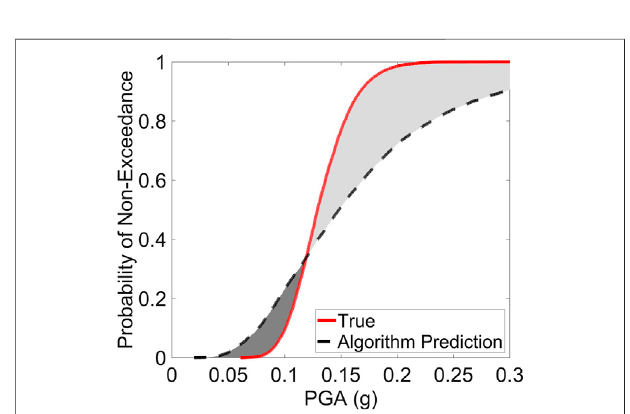
FIGURE 4 | Demonstration of the GMM evaluation procedure, which measures the difference between the true and estimated GMM CDF for a given set of location and magnitude predictions. The light gray shading indicates PGA exceedance thresholds for which the predicted ground shakingisgreater than the true value, which may leadtoa falsealert. The dark gray shading indicates exceedance thresholds for which the predicted shaking is less than the true value, which may lead to a missed